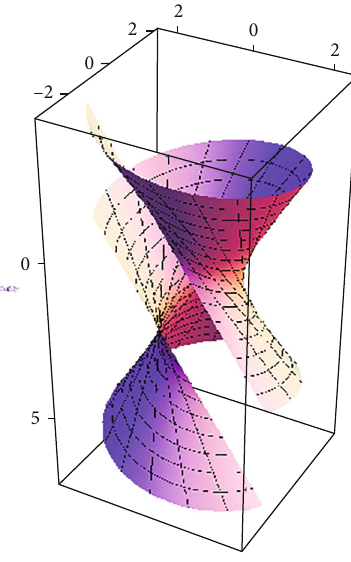
Figure 4: ð X Þ with h = 1 and ψ ∗ = 0 : 5 :